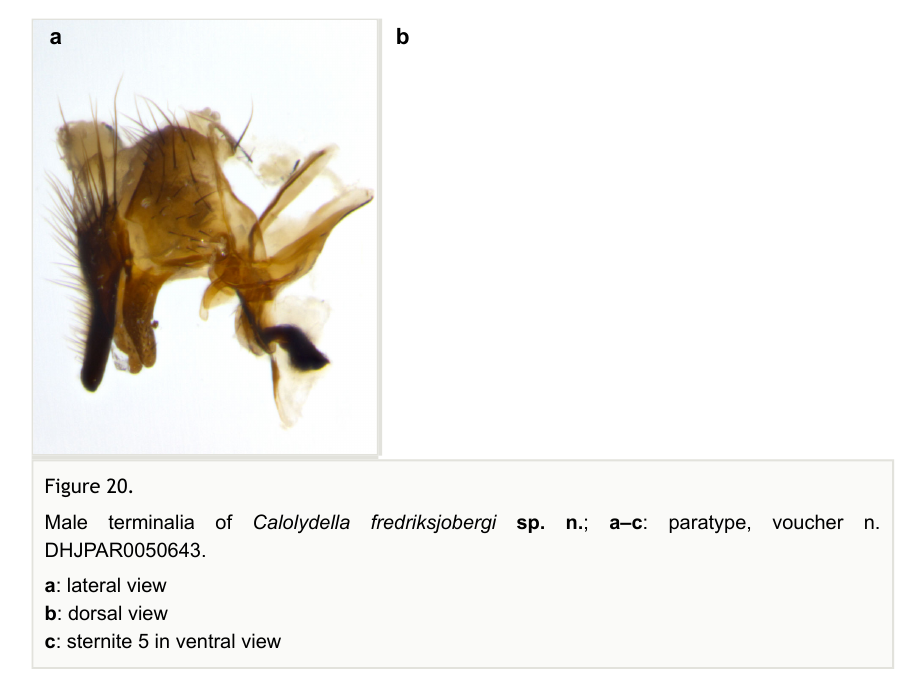
Female (Fig. 19d, e, f). Length: 5–6mm. Fronto-orbital plate 2.2X wider than in male; thoracic vittae 0.5X as wide as in male.